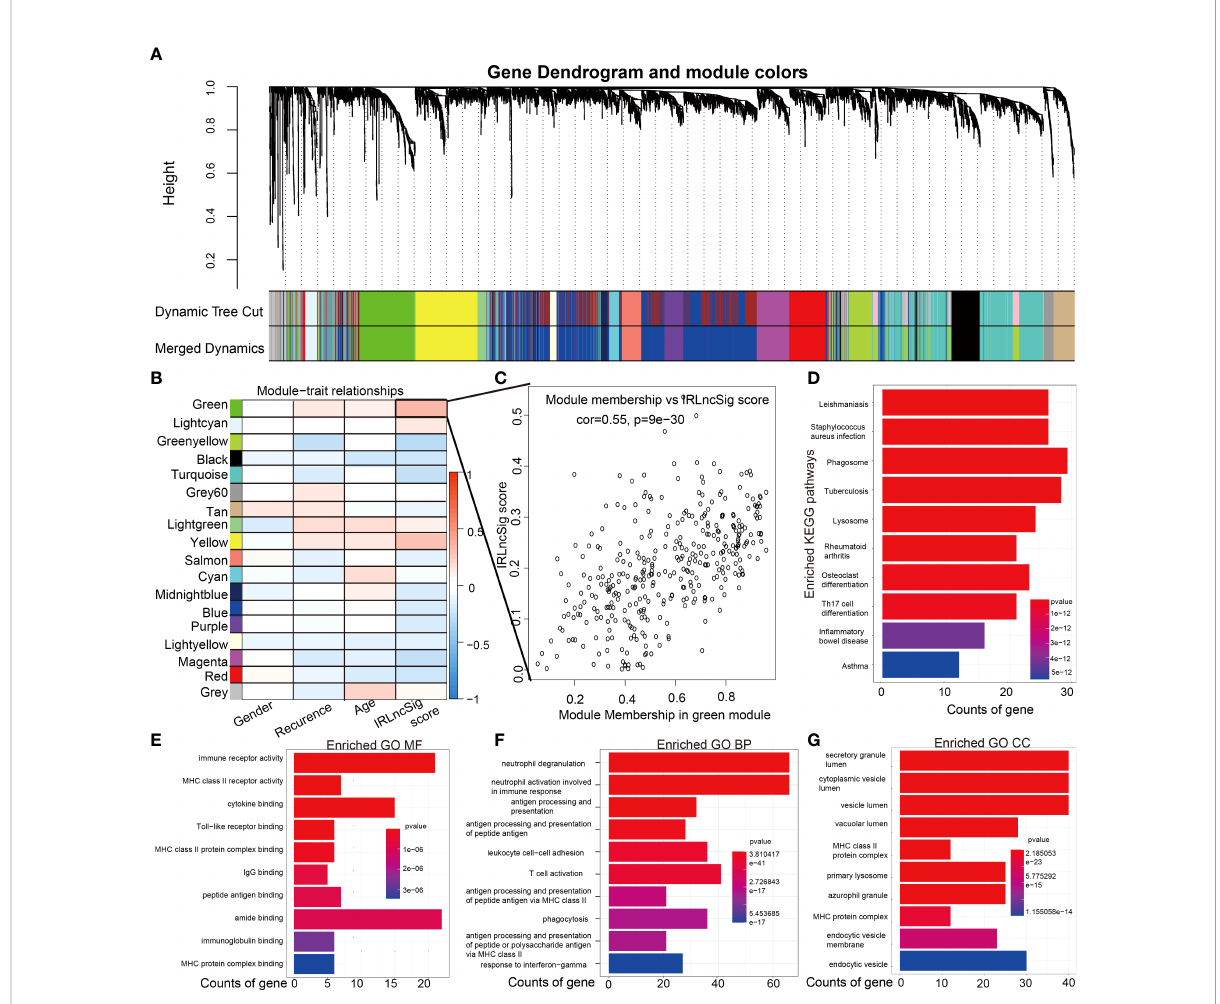
FIGURE 5 Identi fi cation of modules associated with the IRLncSig score and play enrichment analysis of ir-lncRNAs enrolled in IRLncSig. (A) The dendrogram of all genes is clustered based on the WGCNA algorithm. The color shows different clustering modules. (B) Heatmap of the correlation between the module eigengenes and clinical and molecular traits of GBM. (C) Correlation analysis of module membership in the selected module and IRLncSig score. (D) KEGG enrichment analysis is based on the genes in the selected module. (E – G) GO enrichment analysis is based on the genes in the selected module (molecular function (MF, Figure 6E), biological process (BP, Figure 6F), and cellular component (CC, Figure 6G)). IRLncSig, immune-related lncRNA signature; ir-lncRNAs, immune-related long noncoding RNAs; GBM, glioblastoma multiforme; KEGG, Kyoto Encyclopedia of Genes and Genomes, GO, Gene